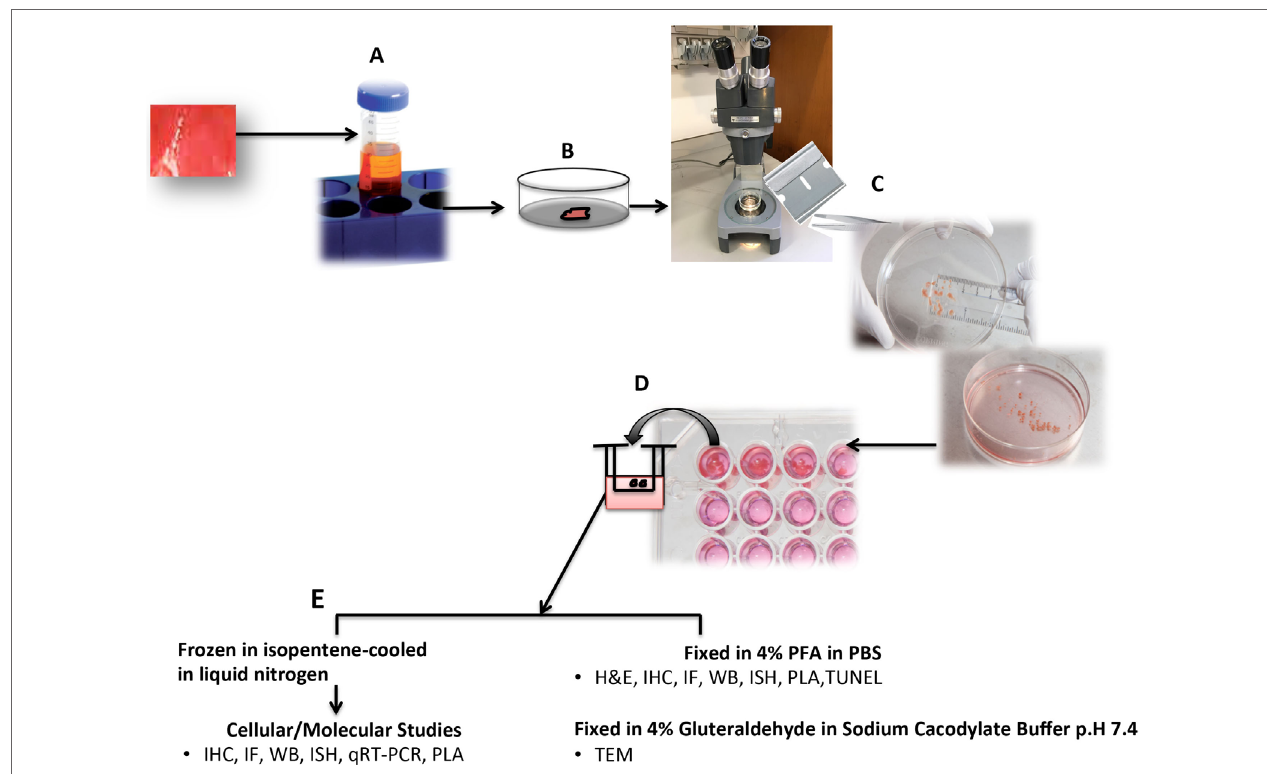
FiGURe 1 | Schematic diagram of human organ culture (HOC) setup. Tissue is immersed in a sterile universal container with tissue culture medium (M199 supplemented with 5% heat-inactivated fetal calf serum, 100 U/ml penicillin/streptomycin, 2.2 mM l -glutamine) (A) . Tissue is rinsed in sterile phosphate-buffered saline (PBS) to remove excess blood (B) . Tissue is dissected under a dissecting microscope using two sterilized carbon steel razor blades single-edged stuck together creating a gap of < 1 mm 3 (C) . Tissue fragments are immersed in sterile 96-well plate containing 200 µl medium and sterile culture insert, treated as indicated, or left untreated and maintained in a 37°C incubator (95% air, 5% CO 2 ) for the indicated time periods (usually less than 24 h) (D) . Upon harvest, HOCs are either immersed in fixative (paraformaldehyde for light microscopy or gluteradehyde for electron microscopy) or in RNA later or snap-frozen in